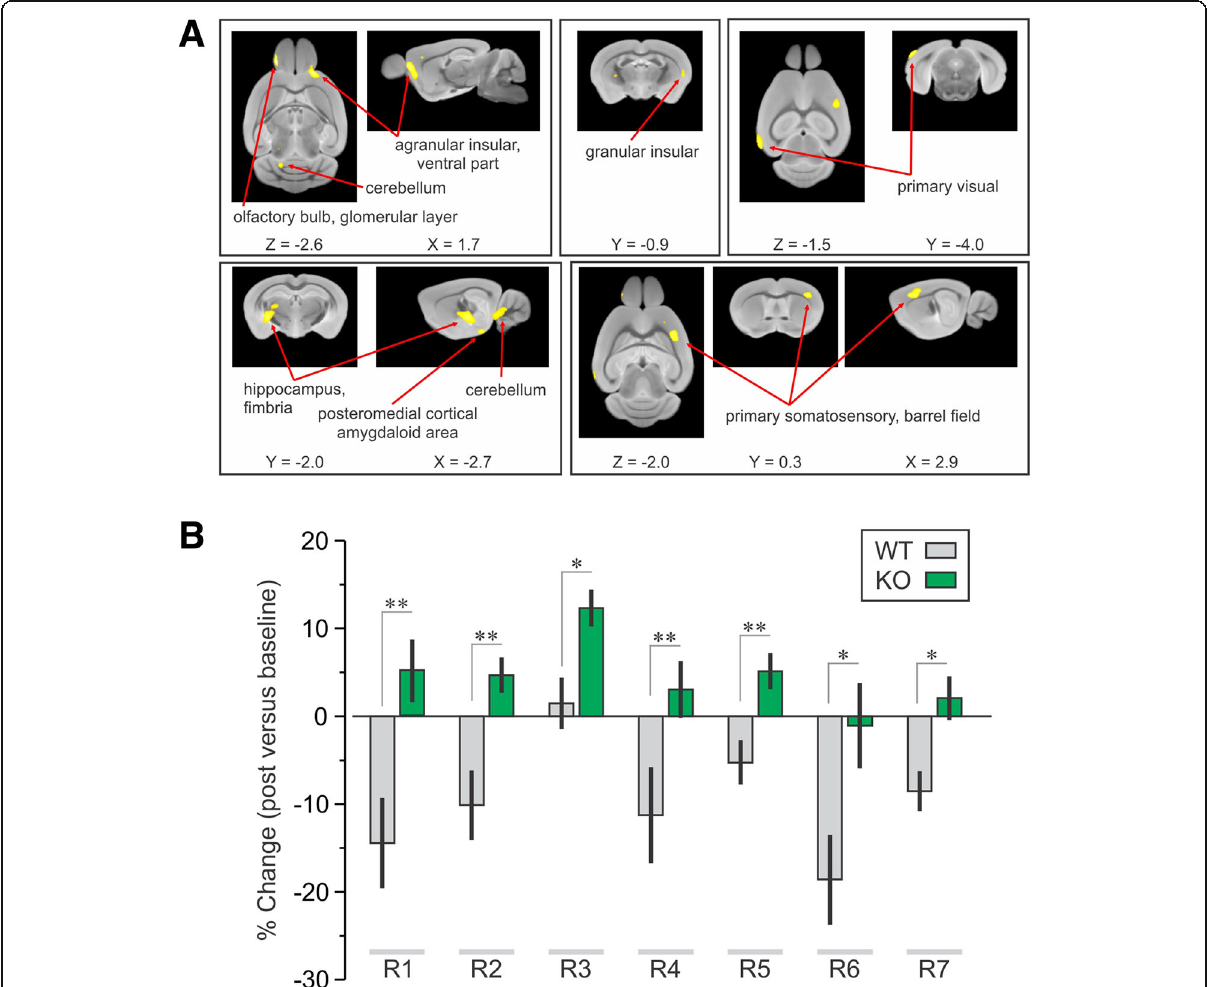
Fig. 2 Deficiency in CIRP reversed the decreased regional metabolic activity in the WT mice after binge alcohol. a Regions identified by SPM analysis using two way ANOVA in which metabolic activity was decreased in WT mice but increased in KO mice during post-alcohol were aligned to mouse MRI brain template and regions anatomically identified based on a three dimensional mouse brain atlas (Paxinos and Franklin 2008). b Percent changes in globally normalized metabolic values decreased in WT mice but increased in CIRP − / − (KO) mice over specific regions revealed by the two-way ANOVA. The regions are as follows: R1-Olfactory bulb, glomerular layer, R2-agranular insular cortex, ventral part, R3-cerebellum, 3rd lobule of cerebellar vermis, R4- posteromedial cortical amygdaloid area, R5-hippocampus, fimbria, R6-primary visual cortex, R7-primary somatosensory cortex, barrel field. See Table 2 for the stereotaxic coordinates and anatomic volumes of these regions. Data are expressed as mean ± SE; * P < 0.05, ** P < 0.005, KO vs. WT mice of respective